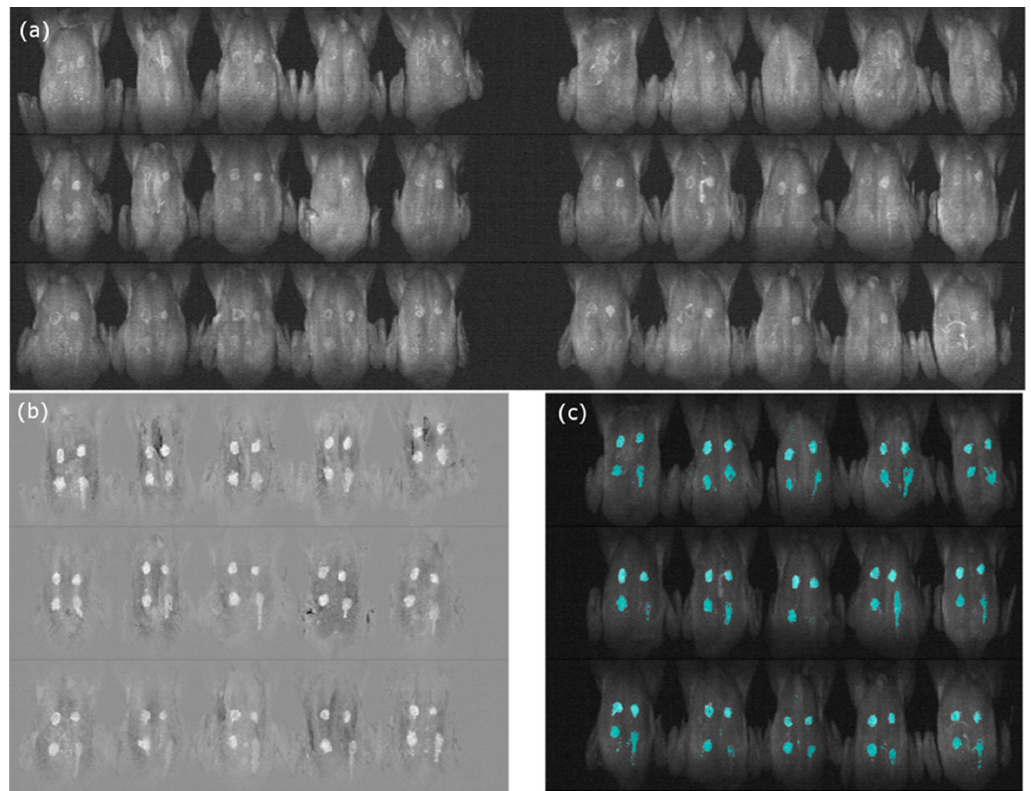
Figure 11. In order to find the optimal threshold value 30 samples ( a ) were used. PC2 employed ( b ) and selected the optimal threshold value (155) and its validation using the threshold value with artificial color ( c ).